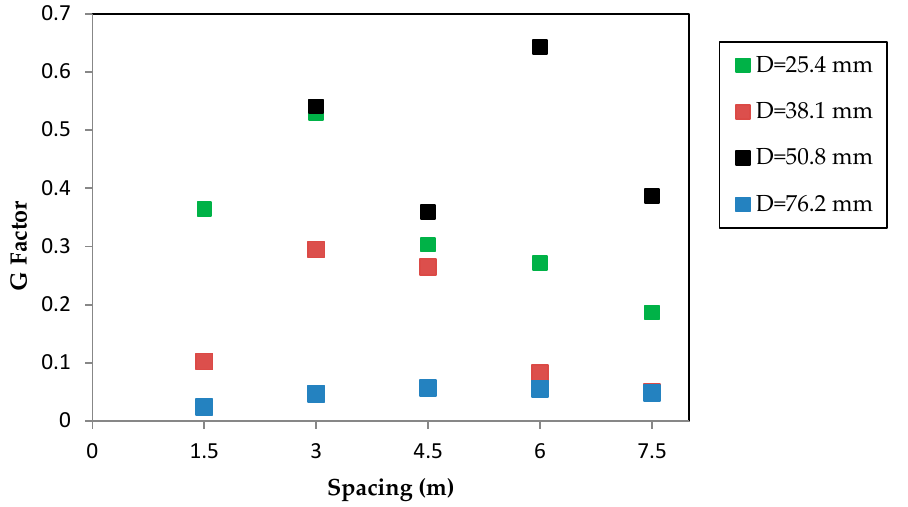
Figure 8. Variation of the experimental G factor for various outlet spacings (inlet head = 2.2 m).